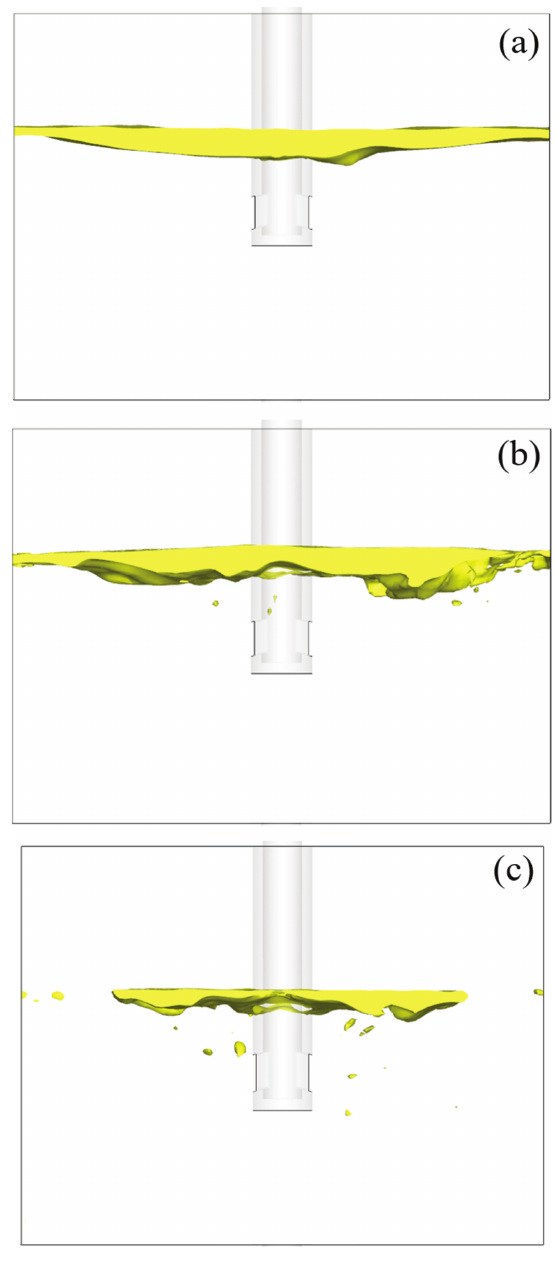
Figure 10: The slag profile and the water – oil interface in the simu- lation at different casting speeds: (a) 0.9m/min, (b) 1.3m/min, and (c)